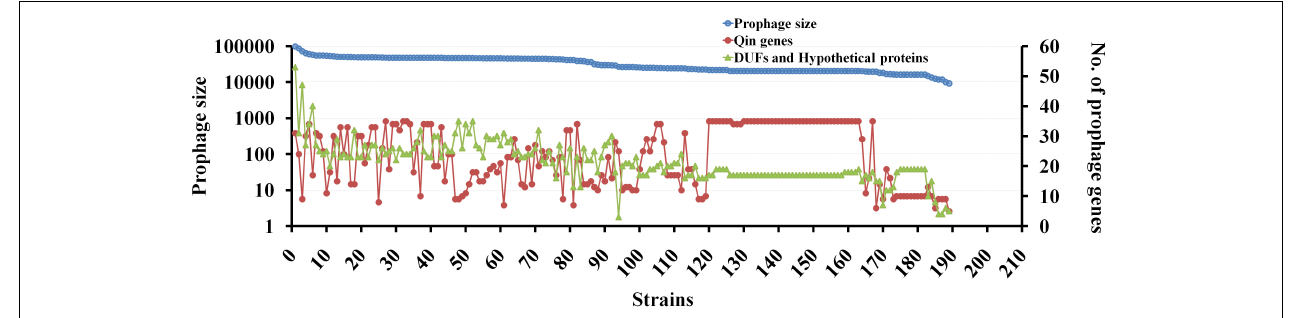
FIGURE 6 | The genetic diversity of Qin prophage in various E. coli strains. Correlation between the prophage size and the number of genes carried within the prophage is studied using BLAST tool and curated in excel. For each strain, the length of site- specific Qin prophage and the number of prophage encoding proteins were obtained using BLASTn tool taking gene sequence of each gene as query and hits are curated using excel. The dependence of prophage size and the flux of genes are represented in a scatter plot as shown taking prophage size on primary Y -axis, the number of genes on the prophage as secondary Y -axis and 189 strains on the X -axis. For Qin prophage analyses, the prophage coordinates were used to estimate the prophage size. Having E. coli MG1655 as the reference strain, the number of genes carried on Qin prophage among 189 strains was noted. The number of DUFs (Domain of Unknown Function) and hypothetical proteins in Qin prophage of each strain was fetched using a JavaScript to search the GenBank files of each prophage for “DUF” and “hypothetical proteins.” The graph was plotted to present the diversity of prophage in terms of its size, the number of genes carried, and novel genes in each of the